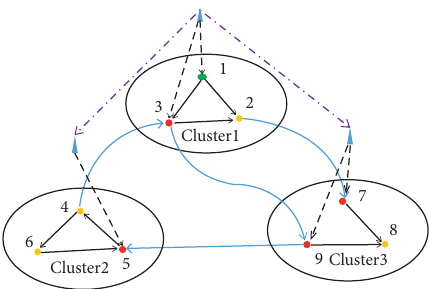
Figure 1: The graph of a multitracking model. The k th leader is denoted by triangle dot. The i th agent is labelled with i and denoted by circle dot, i � 1 , 2 , ... , 12; k � 1 , 2 ,